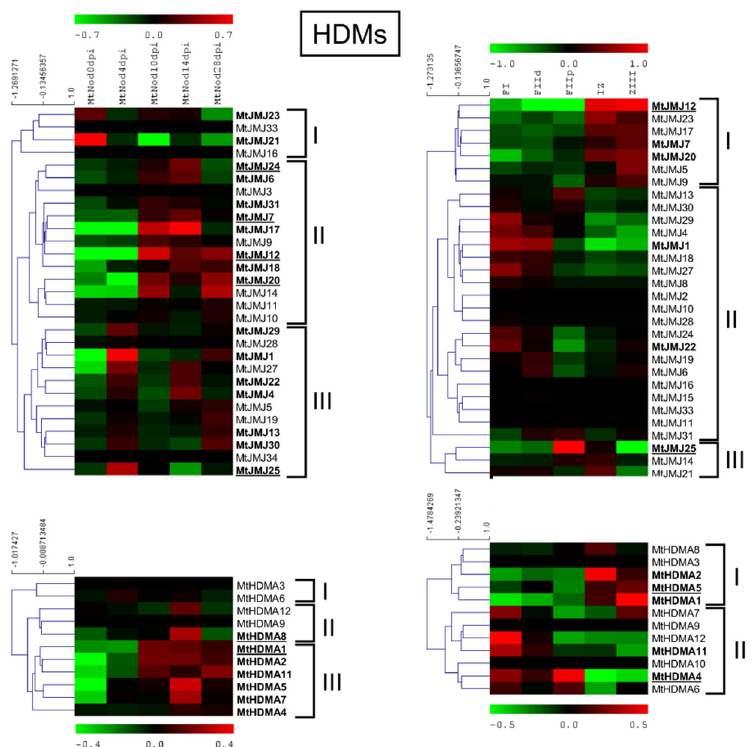
Figure 7. Heat map of MtHDMs in the ND experiment (on the left) and the LCM experiment (on the right). The main clusters are indicated by square brackets. In bold are the genes with an average expression above five in the ND experiment and above two in the LCM experiment. Genes with higher expression are underlined.